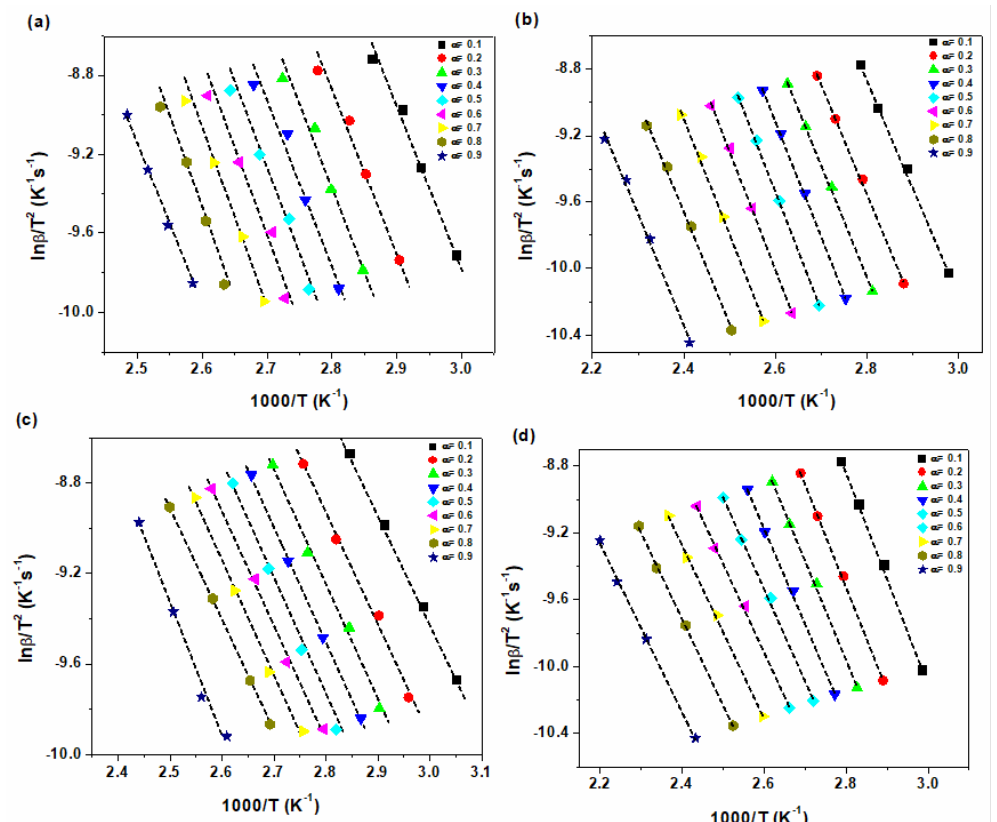
Figure 4. Plots of ln( β / T 2 ) vs. 1 / T for ( a ) epoxy resin, ( b ) epoxy / P-HNT and ( c ) epoxy / A-HNT and ( d ) epoxy / F-HNT nanocomposites based on KAS model.